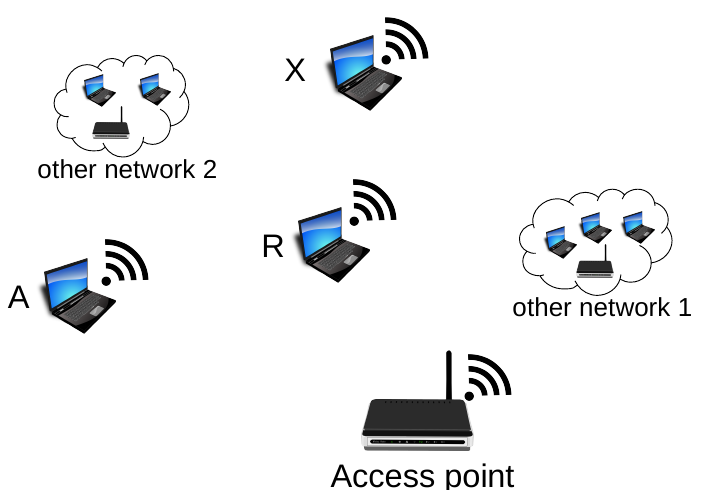
Figure 9. The experiment setup for “One-informed” variant. A—station transmitting covert informa- tion; X—the non-informed station; R—covert information receiver